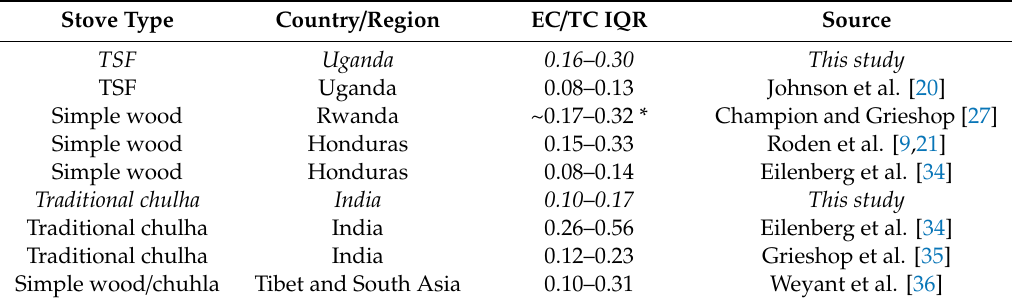
* Approximate values based on visual interpretation of boxplot in source